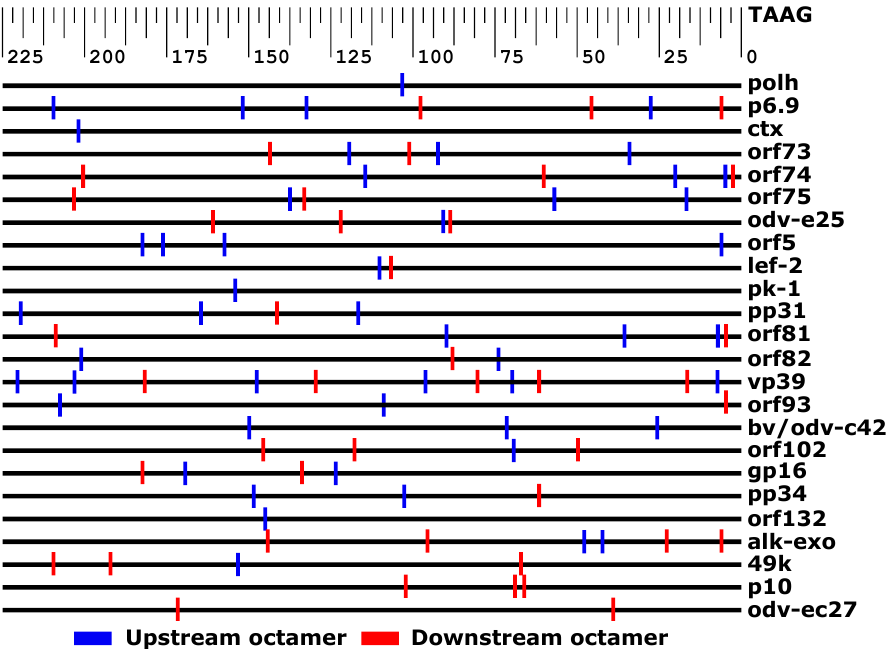
Figure 7. The approximate positions of the upstream octamer (blue) and downstream octamer (red) in regions upstream of the late gene promoter motif for the most abundant Ac MNPV